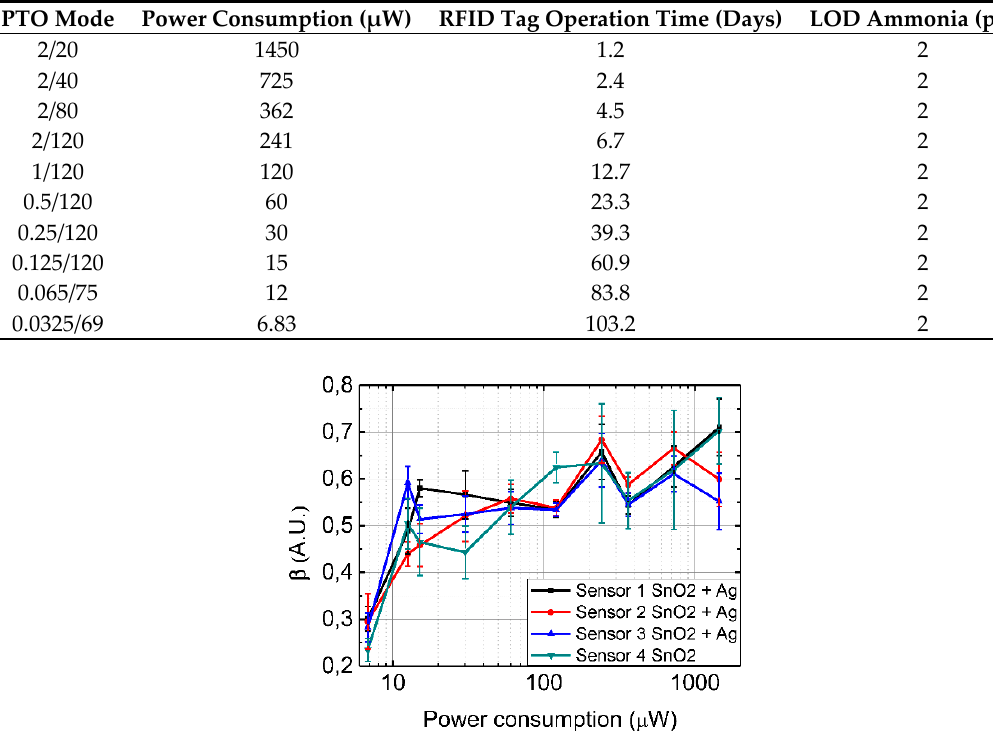
Figure 3. Sensor sensitivity to